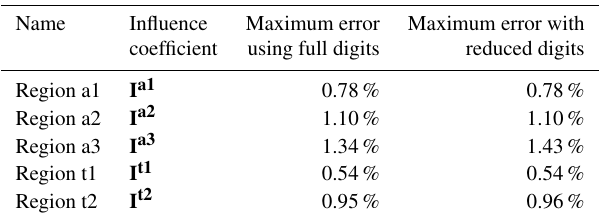
Table D1. The relative error of the convective correction using the influence coefficients with full digits or reduced